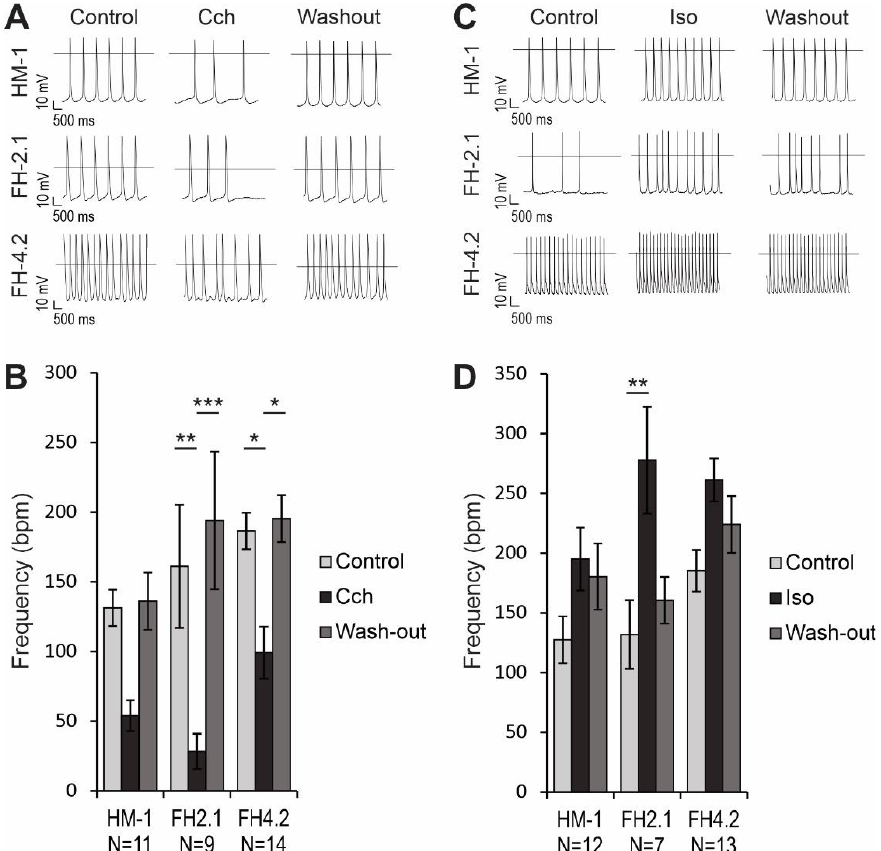
Figure 6. Effect of carbachol (CCh) and isoproterenol (Iso) on HM-1-ESC- and FH-PSC-derived CMs. Negative chronotropic effect of 1 μM CCh ( A , B ) and 1 μM Iso ( C , D ) on HM-1 CMs, FH-2.1 CMs, Negative chronotropic effect of 1 µ M CCh ( A , B ) and 1 µ M Iso ( C , D ) on HM-1 CMs, FH-2.1